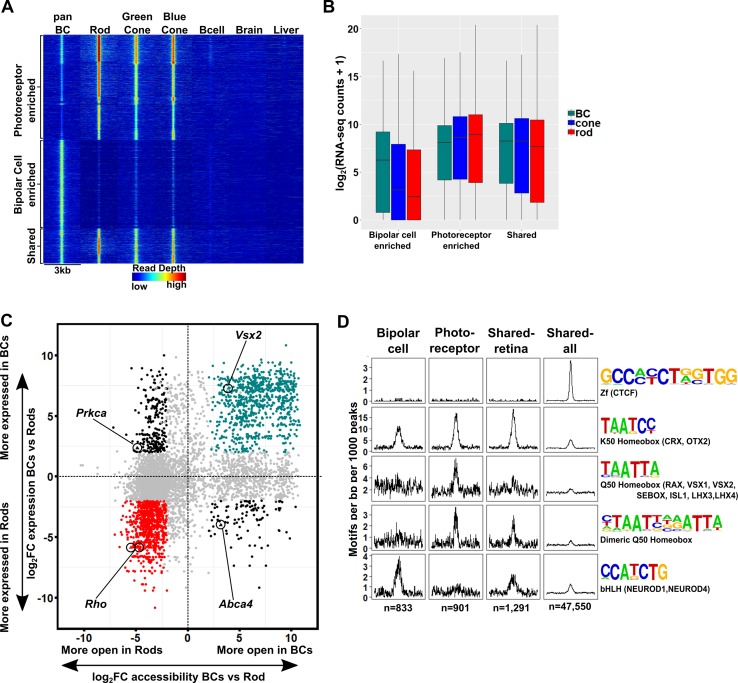
The cis-regulatory grammar of genomic regions associated with differential chromatin accessibility and gene expression in bipolar cells and photoreceptors.(A) Heatmap depicting 8,435 genomic regions determined by pairwise comparison to be differentially accessible in photoreceptors, bipolar cells, or both cell classes, compared to adult mouse B cells, brain and liver. Photoreceptor-enriched (n = 3,874), bipolar cell-enriched (n = 3,270), shared (n = 1,291). (B) Expression of genes to which classes of peaks defined in A were assigned by proximity to nearest TSS. There is a moderate correlation between chromatin accessibility and gene expression in each cell class. (C) Peaks identified in panel A are plotted according to chromatin accessibility (x-axis) and associated gene expression (y-axis) in bipolar cells versus rods. Peaks with four-fold greater chromatin accessibility and associated gene expression in bipolar cells are shown in green (FDR < 0.05 for both accessibility and expression), while those peaks with greater accessibility and associated gene expression in rods are shown in red. Shared peaks and those associated with modest (less than four-fold) differences in expression are in gray. Peaks with discordant chromatin accessibility and associated gene expression are shown in black. Peaks assigned to genes expressed specifically in photoreceptors (Rho, Abca4) or bipolar cells (Vsx2, Prkca) are indicated. (D) Motif enrichment within peaks displaying correlated chromatin accessibility and associated gene expression in bipolar cells and photoreceptors as well as within peaks displaying shared accessibility, including those shown in panel A (shared-retina) and shared peaks which were not filtered to remove those accessible in non-retinal tissues (shared-all). Both photoreceptor and bipolar cell peaks show enrichment for K50 HD motifs. Bipolar cell peaks (n = 833) are also highly enriched for E-box motifs but lack enrichment of Q50 HD motifs. In contrast, photoreceptor peaks (n = 901) show enrichment for Q50 HD motifs but almost entirely lack E-box enrichment. Shared retina-specific peaks (n = 1,291) show a hybrid pattern of motif enrichment. Only the shared-all peak set exhibits enrichment for CTCF motifs, underscoring a key difference between cell-class specific open chromatin regions (which show no enrichment of CTCF motif) and ubiquitously open chromatin regions, which show strong enrichment.